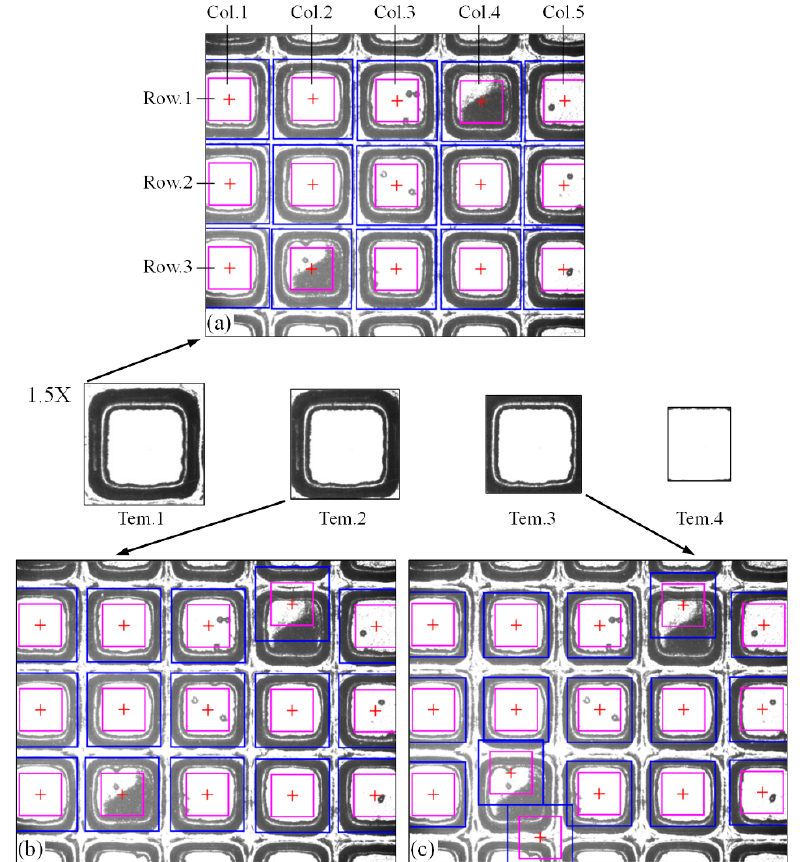
Figure 8. Comparison of template matching results for different templates. ( a ) Matching result of Tem.3; ( b ) matching result of Tem.2; ( c ) matching result of Tem.1.